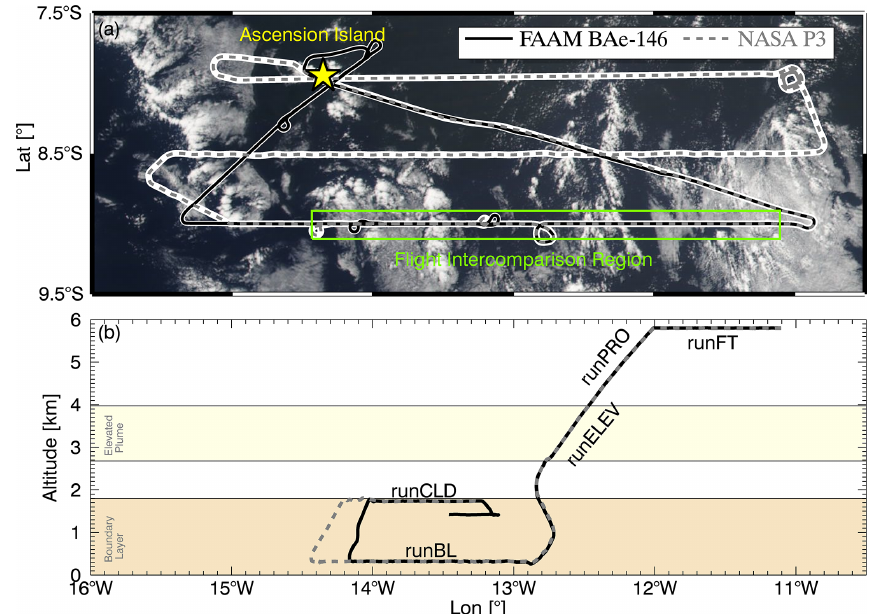
Figure 3. (a) Flight tracks for both the FAAM BAe-146 and NASA P3 flights with the intercomparison flight segment marked (green box), overlaid on Visible Infrared Imaging Radiometer Suite (VIIRS) corrected-reflectance (true colour) imagery from 18 August 2017 (the imagery was obtained from NASA Worldview). (b) Flight vertical cross sections as a function of longitude for the intercomparison segment for FAAM BAe-146 and NASA P3, which commenced at 5.8km. Run names are indicated (see Table 2), along with horizontal bands which mark out the vertically elevated pollution plume (yellow) and boundary layer (light orange). Table 2. Event timing markers during FAAM C031/NASA PRF05Y17 intercomparison flight on 18 August 2017 and FAAM-LASIC ARM site intercomparison flight legs on 6d between 17 August and 5 September 2017. FAAM Altitudes are GPS-corrected to WGS84